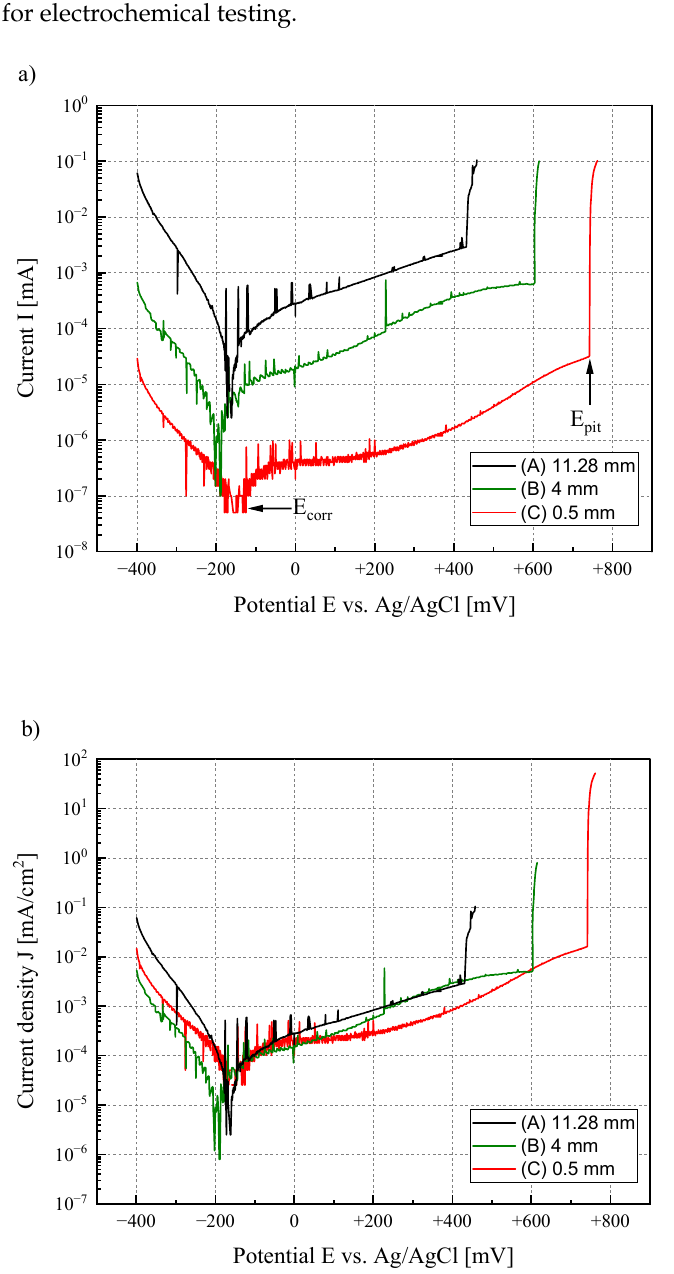
Figure 3. Representative current-potential curves ( a ) and current density-potential curves ( b ) for different diameters of the test area of the 1.4016 at a chloride ion concentration of 500 mg/L.